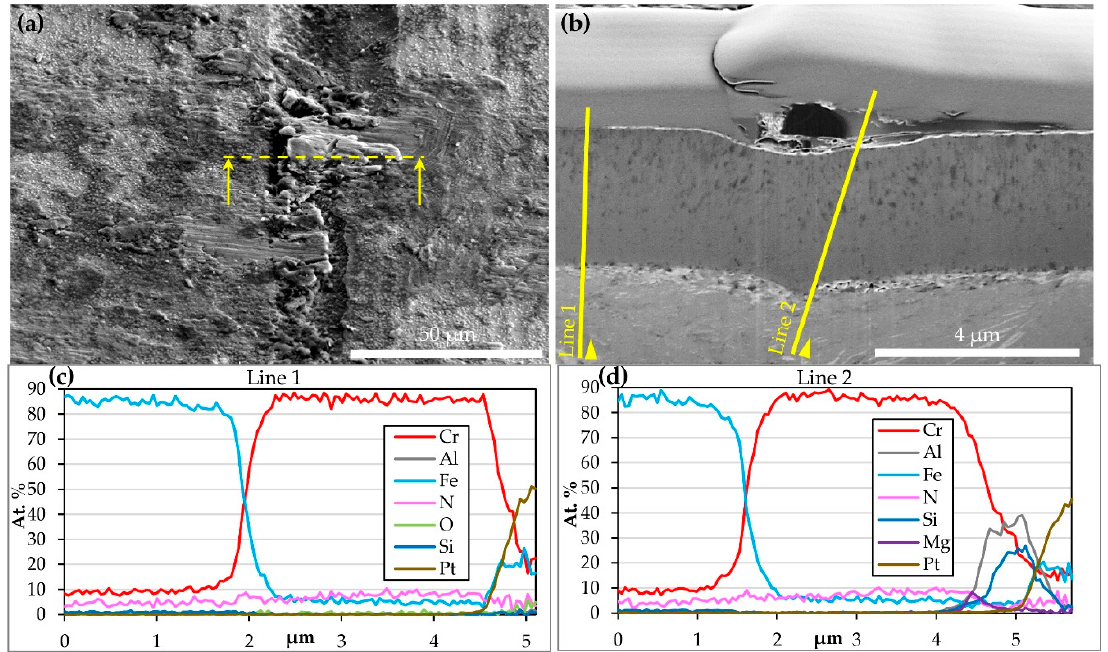
Figure 4. Focused ion beam (FIB) analysis of the CrN-R pin sample with aluminum built-up after casting solidification (CS) experiment, ( a ) secondary electron image, line and arrows indicate FIB milling line and the direction of cross section observation, ( b ) cross-sectional ion induced secondary electron image, ( c ) and ( d ) chemical composition obtained by EDS analysis conducted on cross section along lines drawn in the image (b).